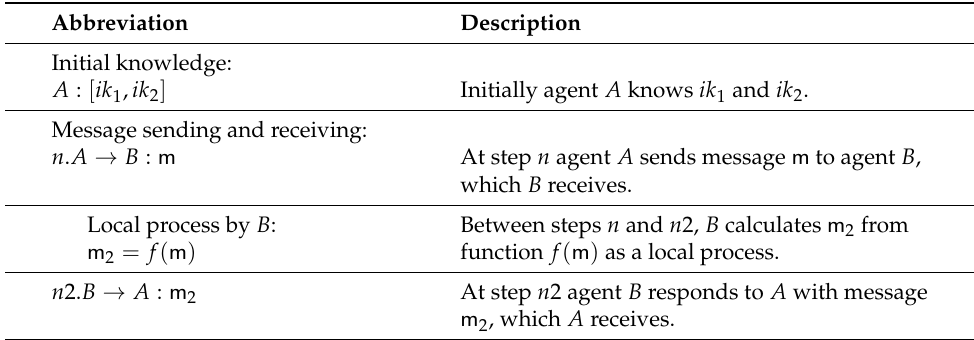
Table 1. Conventions of a security protocol.